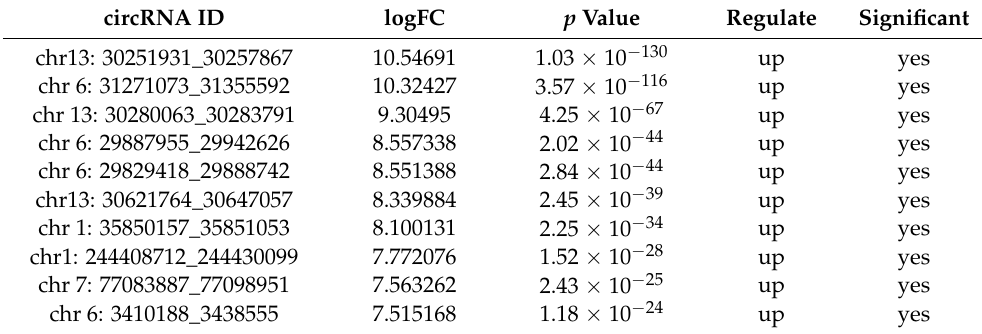
Figure 1. Differentially expressed circRNAs profiles. The heatmap (cluster analysis) was used to detect the significant differentially expressed circRNAs ( A ). Red represents high expression and blue represents low expression of circRNAs. Volcano plots were used to assess the circRNAs ( B ) expression variation. The values of X - and Y -axes in the scatter plot are averaged normalized values of each sample. Fold change ≥ 2, p < 0.05. Table 1. The top 10 up-regulated circRNAs in Leishmaniasis patients compared to healthy con- trol